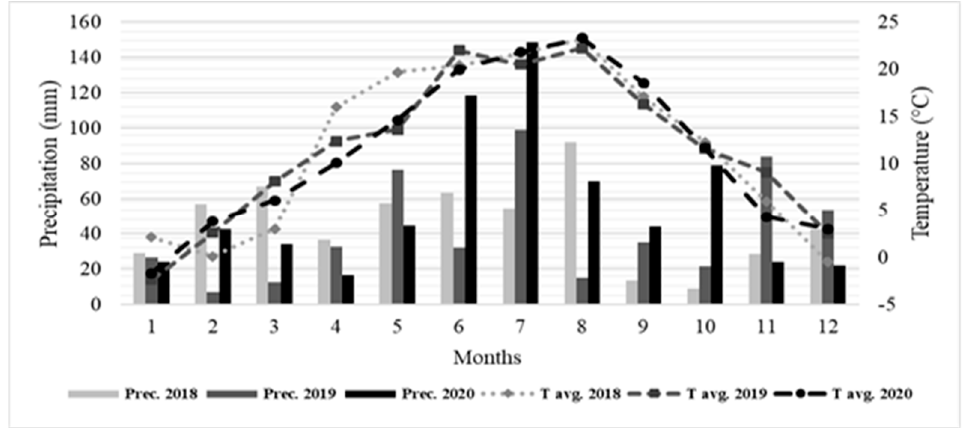
Figure 1. Average monthly temperature and precipitation between 2018–2020 at the Látókép Experiment Site, Hungary.